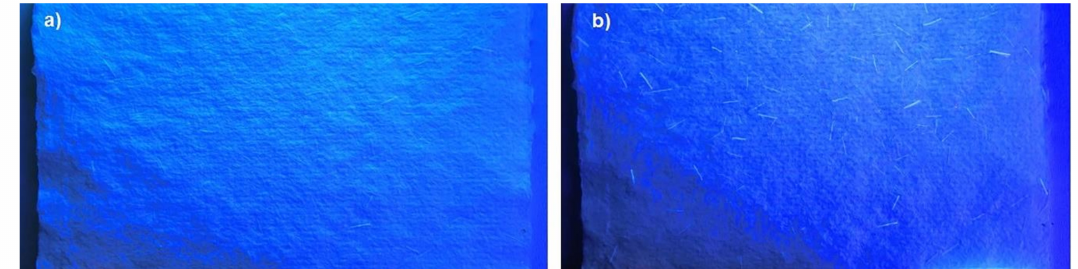
Figure 4. Optical observation of paper modified with fibers containing KMT: ( a ) paper under 254 nm wavelength, no emission of light; ( b ) paper under 365 nm wavelength, visible emission of fibers with KMT.